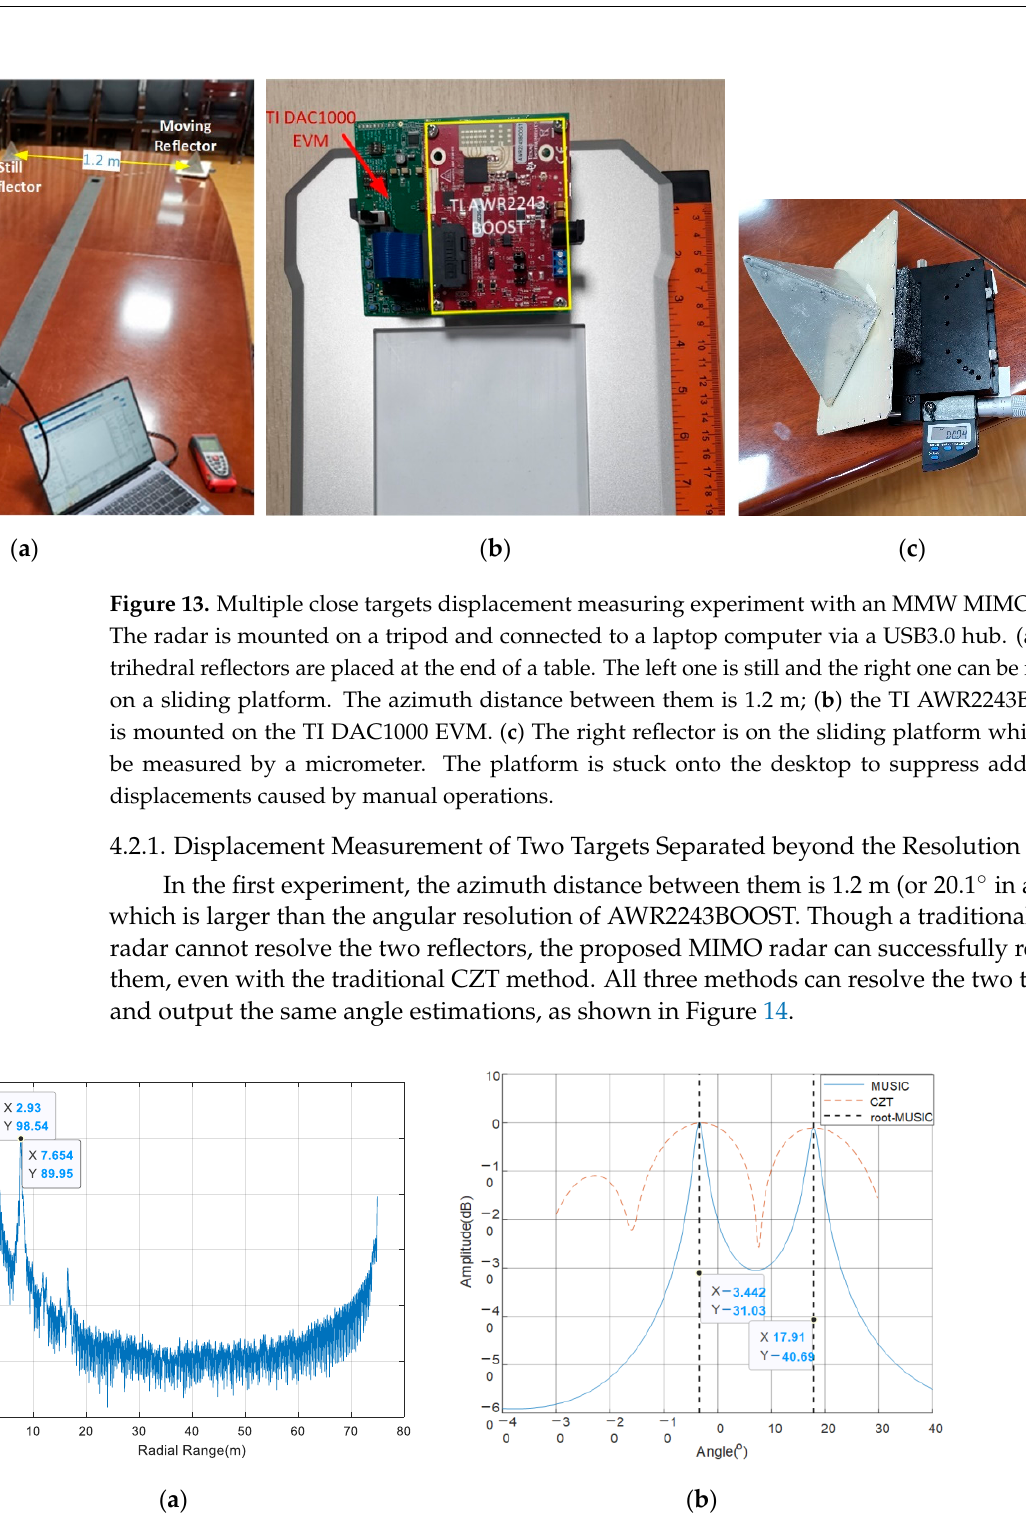
( b ) Figure 12. STD of displacement difference vs. SNR. ( a ) STD of ‘Target1’; ( b ) STD of ‘Target2’. 4.2. Experiments An MMW MIMO radar is designed to measure the displacements of multiple close targets. The MMW MIMO radar is composed of the TI AWR2243BOOST radar front end, the TI DCA1000EVM card, a USB 3.0 hub, and a laptop computer. The experiment is con- ducted on a table with two trihedral reflectors; one is fixed on the left and the other one is mounted on a sliding platform on the right, as shown in Figure 13. Both ranges of the two trihedral reflectors to the radar are 2.9 m. In the two experiments, the sliding platform stays at 0 mm for several seconds; then it is turned to 1 mm and stays for a while; then it is turned to 2 mm and stays for a moment; finally, it is turned back to 0 mm. The sliding platform operator has to hide beneath the table to eliminate his interference with the tri- hedral reflectors. The TI AWR2243BOOST has three transmitting antennas and four re-